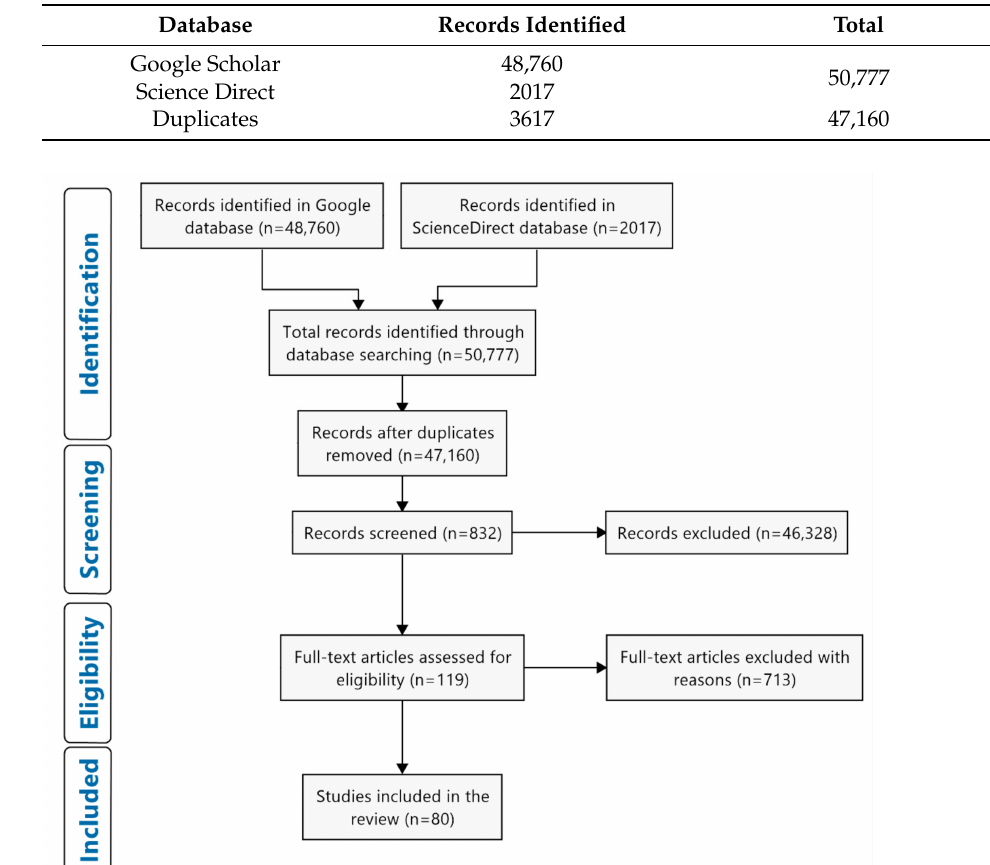
Table 1. Search strategy, custom range 2000–2020.